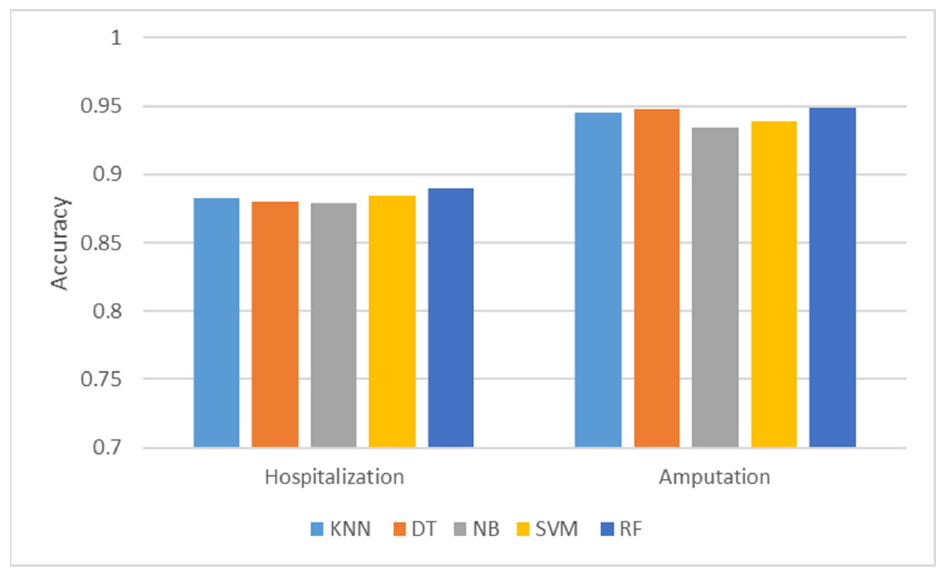
Figure 6. Accuracy Comparison of all ML models; K-Nearest Neighbors (KNN), Decision Tree (DT), Naïve Bayes (NB), Support Vector Machine (SVM), Random Forest (RF)